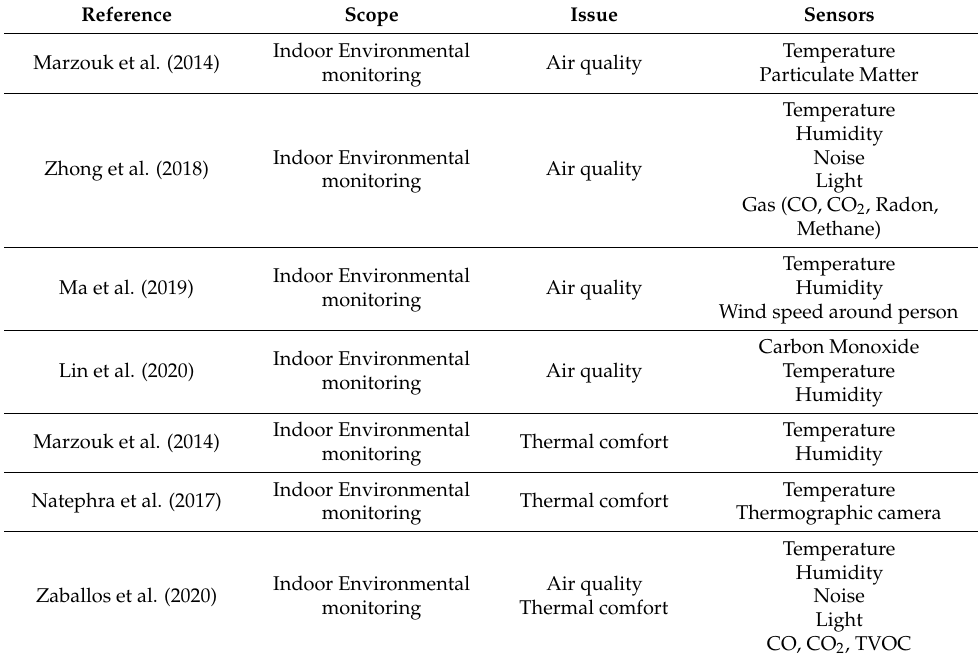
Table 9. Human factor core competence: type of sensors used in studies on BIM–Wireless Sensors Network (WSN) integration for indoor environmental